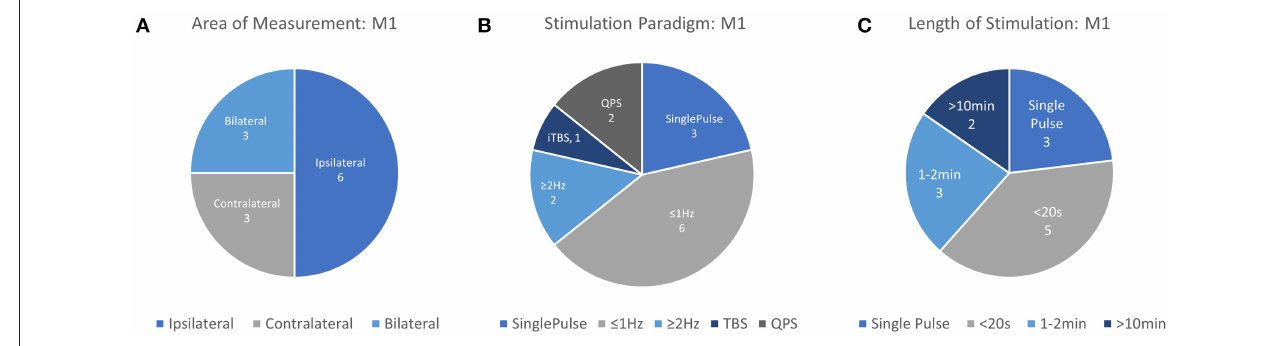
FIGURE 3 | Details of TMS-fNIRS studies applied at rest to M1 for (A) Hemisphere measured, (B) Stimulation paradigm, and (C) Length of stimulation.